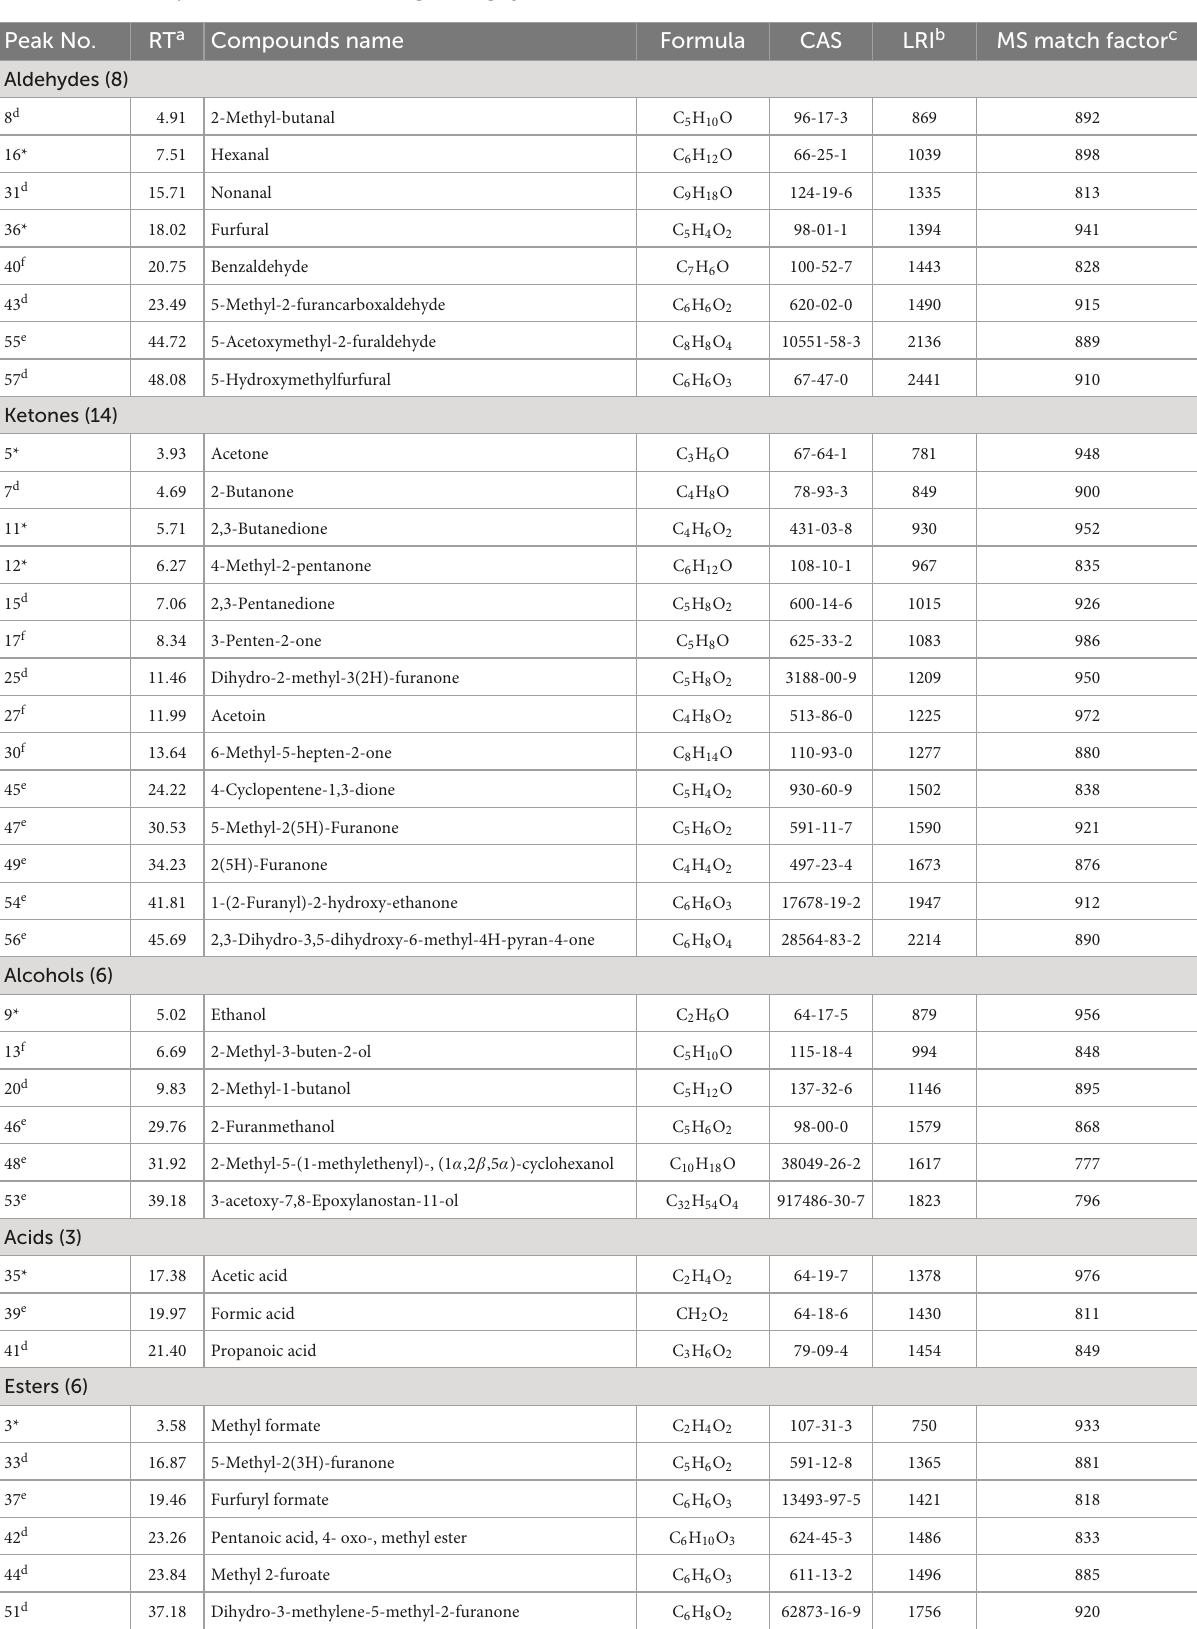
TABLE 1 Volatile compounds identified in CF during roasting by HS-GC-MS. Peak